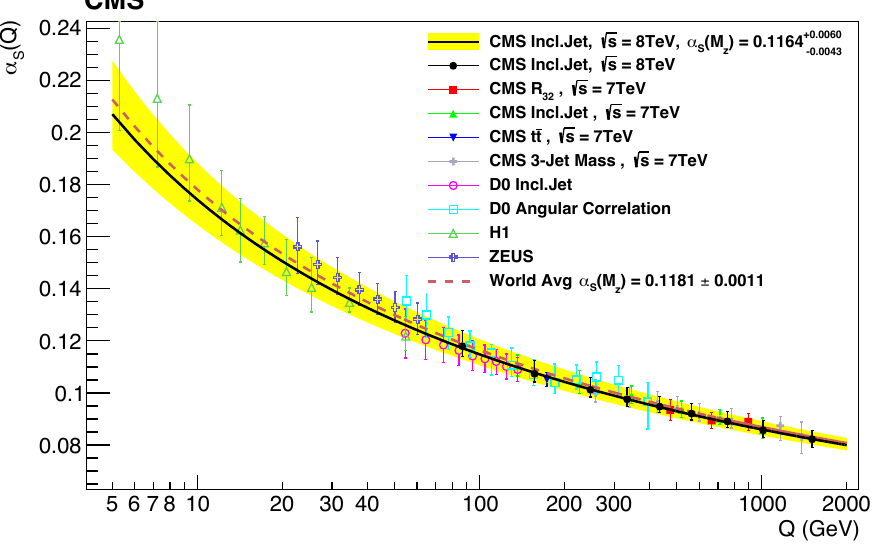
Figure 13 . The running (cid:11) S ( Q ) as a function of the scale Q is shown, as obtained by using the CT10 NLO PDF set. The solid line and the uncertainty band are obtained by evolving the extracted (cid:11) S ( M Z ) values by using the 2-loop 5-(cid:13)avour renormalization group equations. The dashed line represents the evolution of the world average value. The black dots in the (cid:12)gure show the p numbers obtained from the s = 8 TeV inclusive jet measurement. Results from other CMS [53{ 55], D0 [49, 50], H1 [56], and ZEUS [57] measurements are